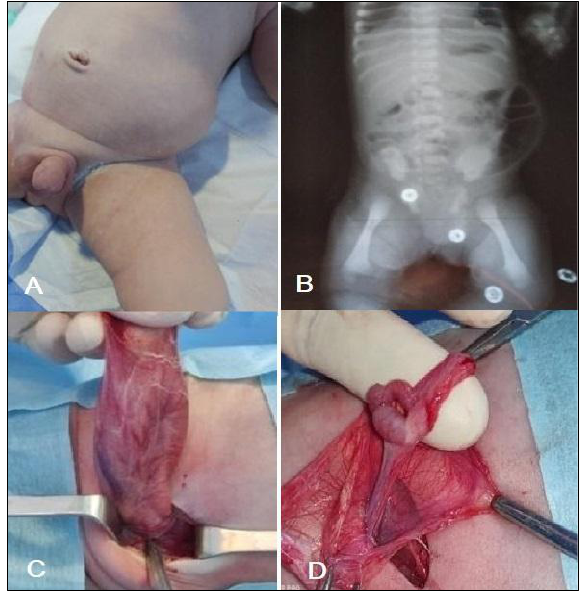
Figure 1: A) Clinical photograph showing SH and right inguinal swelling. B) X-ray of the baby showing gut gas shadow in the SH. C) Sac of the SH. D) Testis is being separated from the